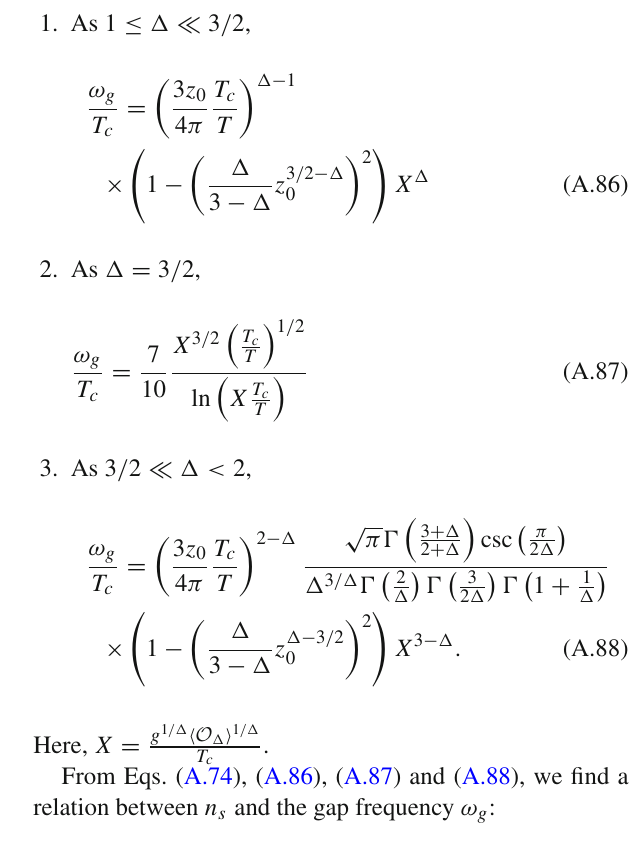
Fig. 22 Solid red curve is a plot of 1 . 1